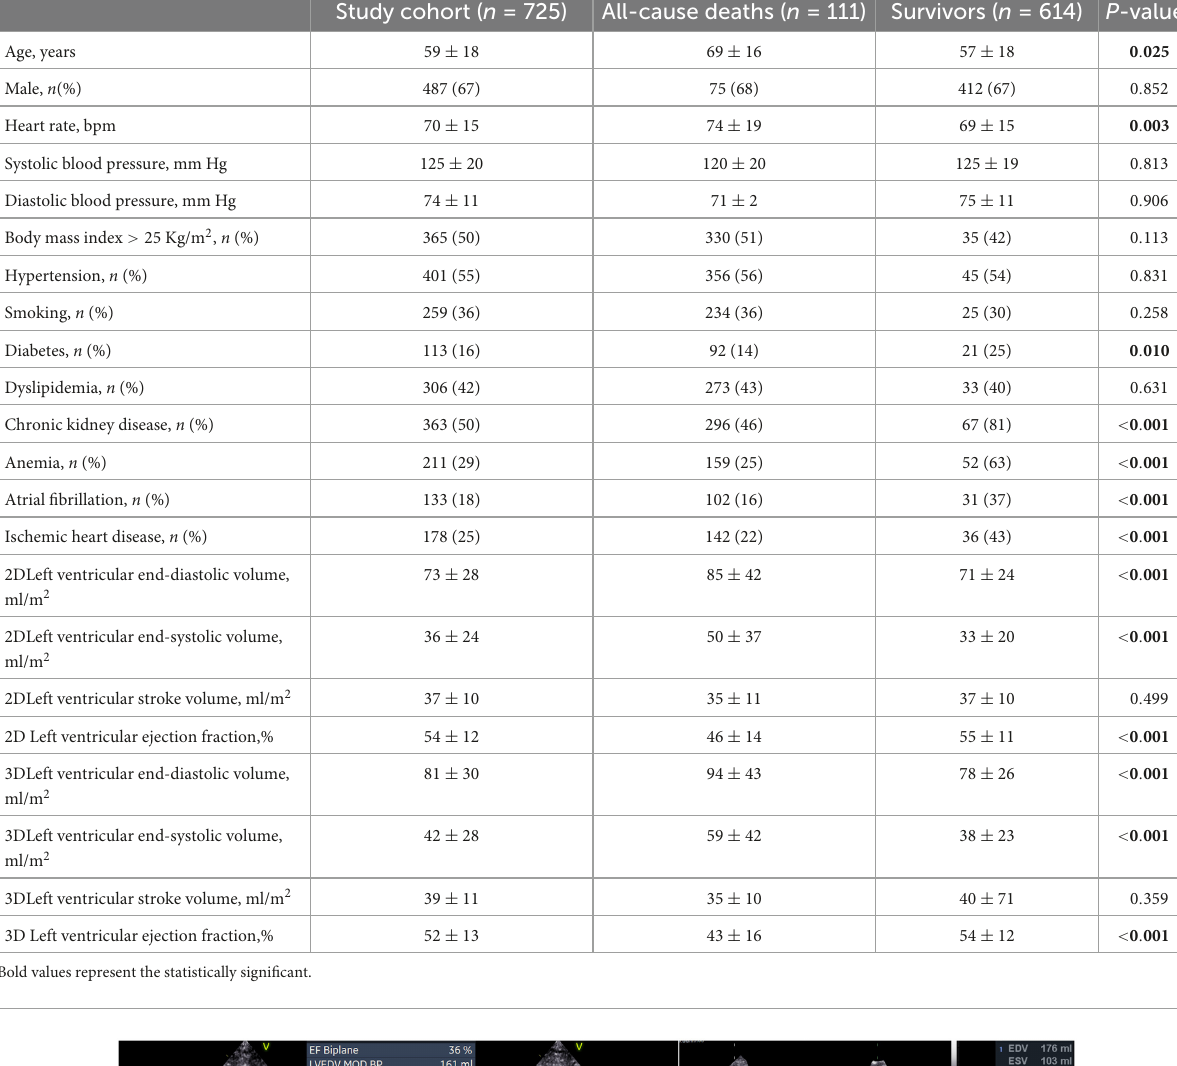
TABLE 1 Clinical and echocardiographic data of the whole study population and their comparison between patients who died and those who survived. Study cohort ( n = 725)